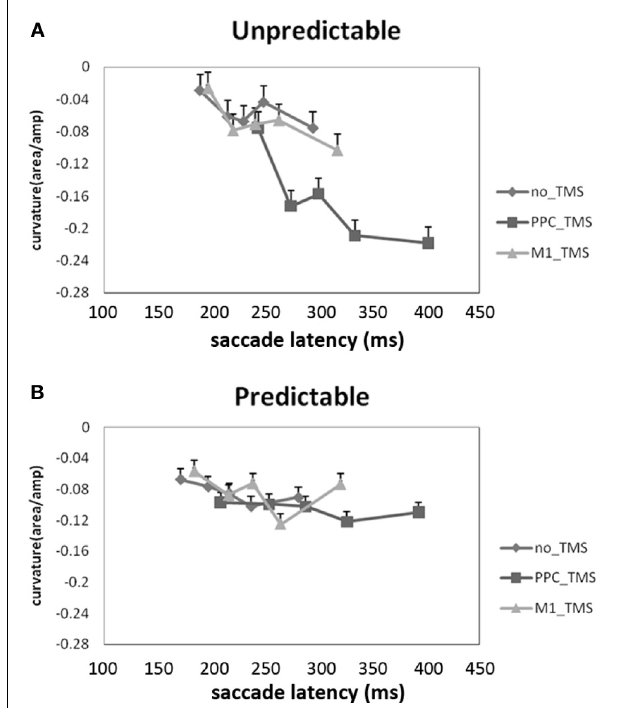
FIGURE 1 | Effect of TMS on PPC in predictable and unpredictable contexts, from Chao et al. (2011). The Y axis denotes the range of saccade curvatures, where negative numbers indicate less curvature toward the distractor. Panel (A) shows that PPC TMS decreased saccade curvature toward the distractor when distractor location is unpredictable, whereas Panel (B) shows that PPC TMS had no effect when distractor location can be predicted in advance. This suggests a critical role for the right PPC in attentional capture, and how predictability can modulate PPC